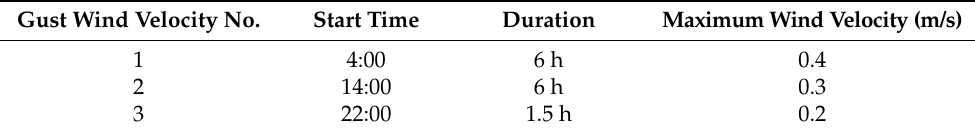
Table A3. Parameters of the gust wind velocity in Scenario I in the case study.